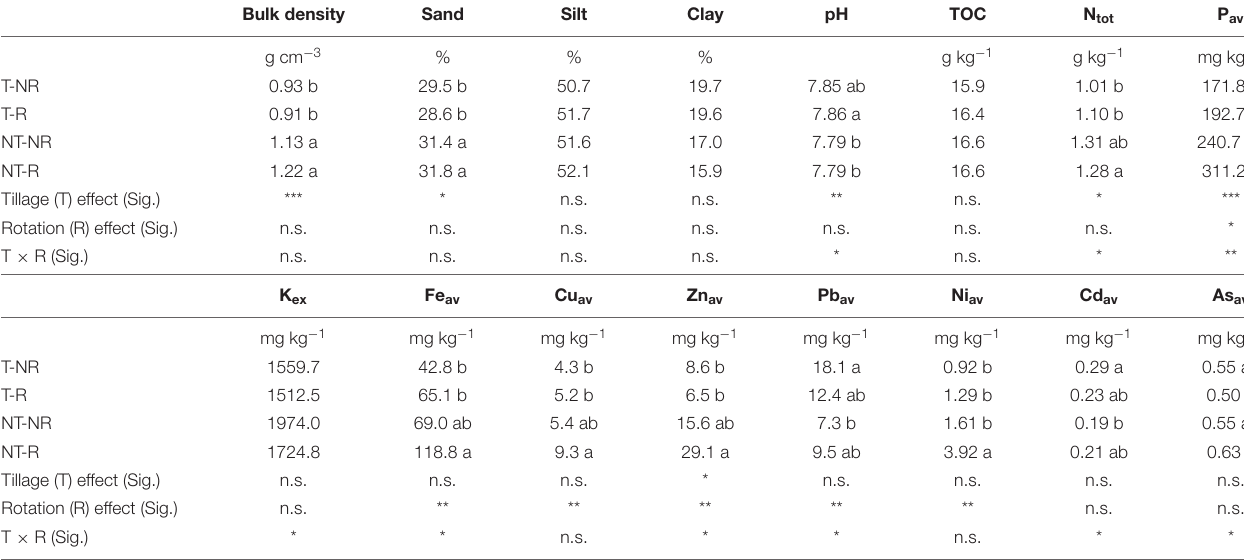
TABLE 1 | Effect of tillage (T/NT), crop rotation (NR/R) and factors’ interaction on main soil chemical-physical